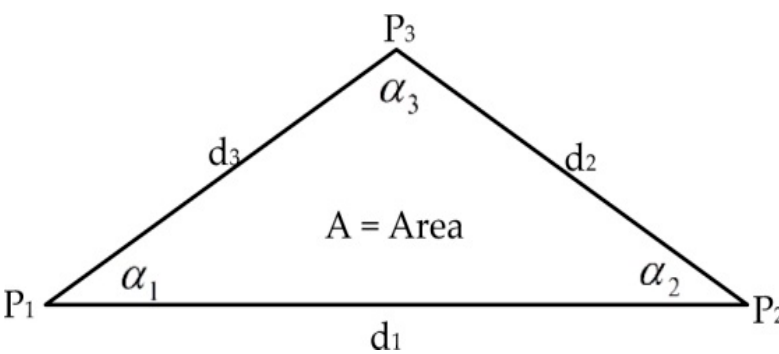
Figure 16. Matching in the case of rigid transformation. ( a ) Set of triangles of vein pattern minutiae of the template. ( b ) Sorted ( a ) in ascending order. ( c ) Reorientation of ( b ) in a normalized position. ( g ) Set of triangles of vein pattern minutiae of the unknown. ( f ) Sorted ( g ) in ascending order. ( e ) Reorientation of ( f ) in a normalized position. ( d ) Matching triangles between ( c ) and ( e ).